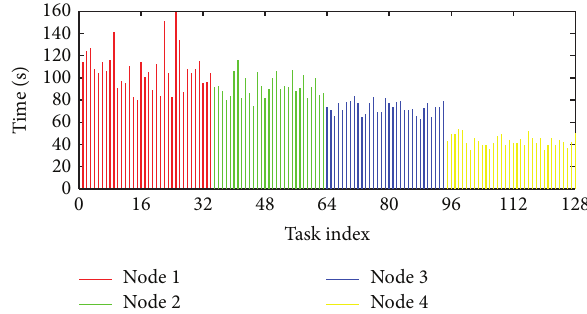
Figure 3: Reorganized execution time of tasks. Tasks in the same node were plotted together.